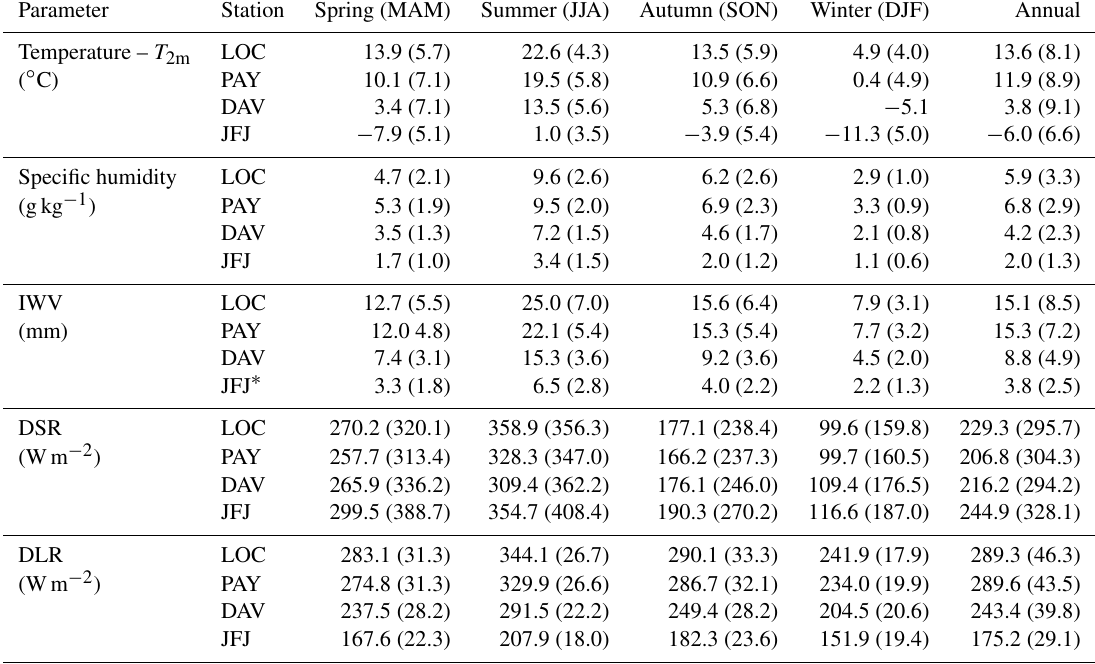
Table 2. Similar to Table 1 except for cloud-free conditions.